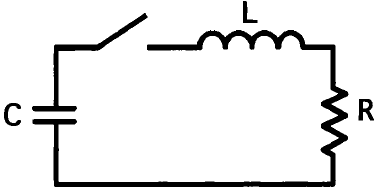
FIG. 7. LTD cavity simplified equivalent circuit. The resist- ance R is the sum of the load and internal circuit impedance. This circuit neglects the core losses.